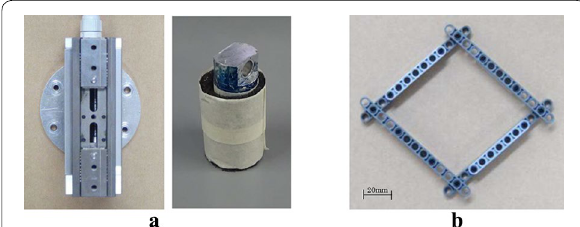
Fig. 12 Experimental equipment. a Two-fingered hand and b object